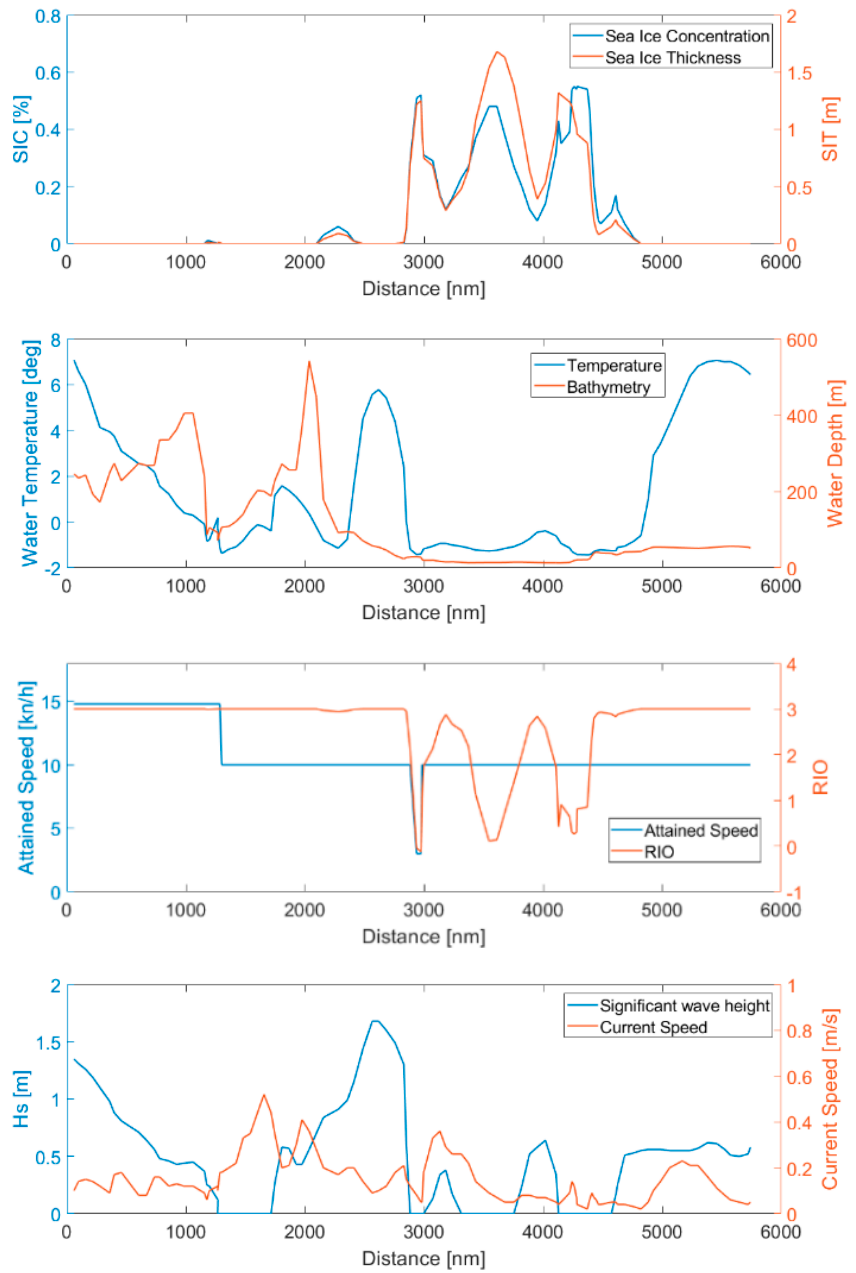
Figure 5. Environmental conditions along with voyages.